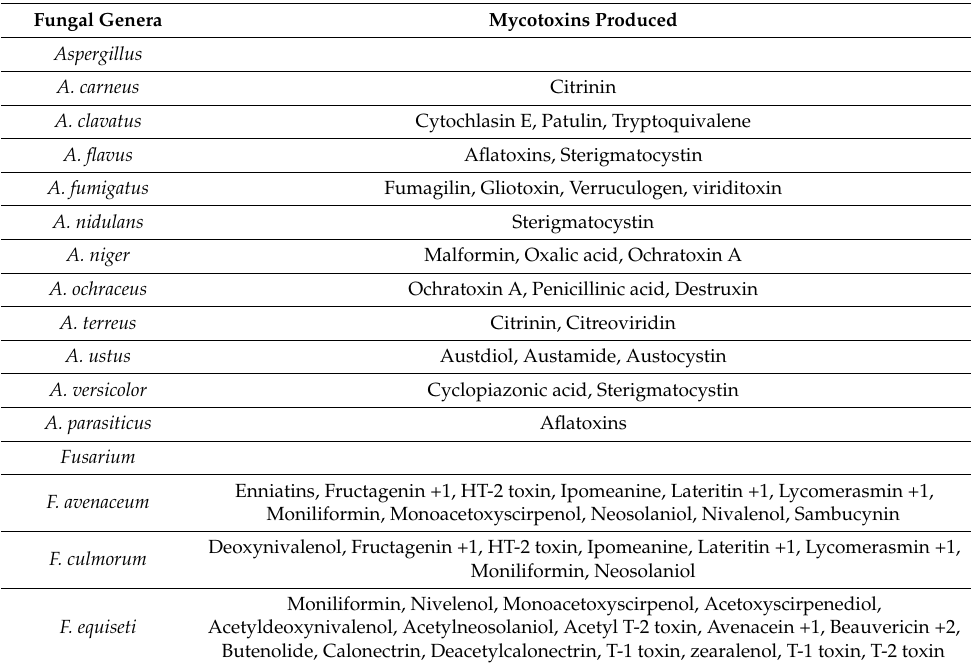
Table 1. Filamentous fungi species and mycotoxins